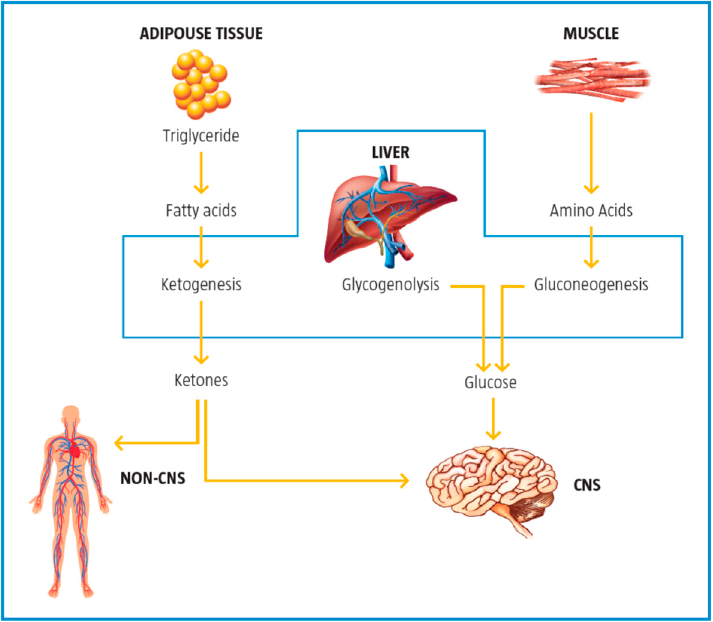
Figure 5. The role of the liver in glucose and fat metabolism. Adapted from Foster, 2004 [21].